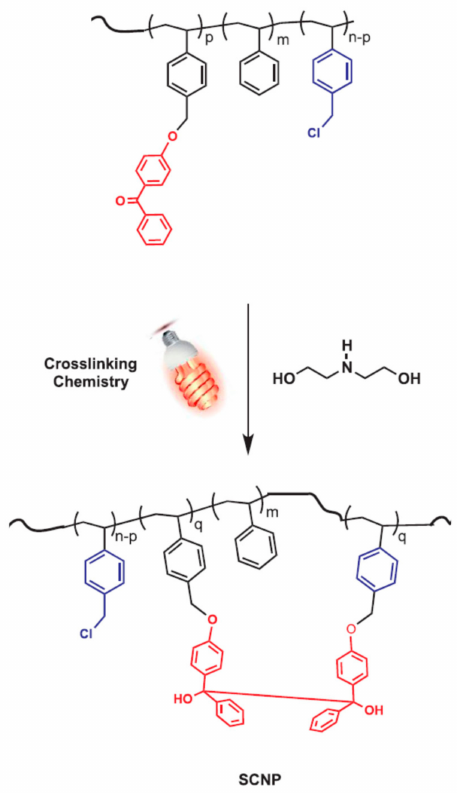
Figure 6. Schematic illustration of the synthesis of SCNPs through intrachain coupling of ketyl radicals from benzophenone units to give benzopinacol moieties under UV irradiation ( λ = 350 nm) in the presence diethanolamine as a hydrogen donor co-initiator. Reprinted from [35] with